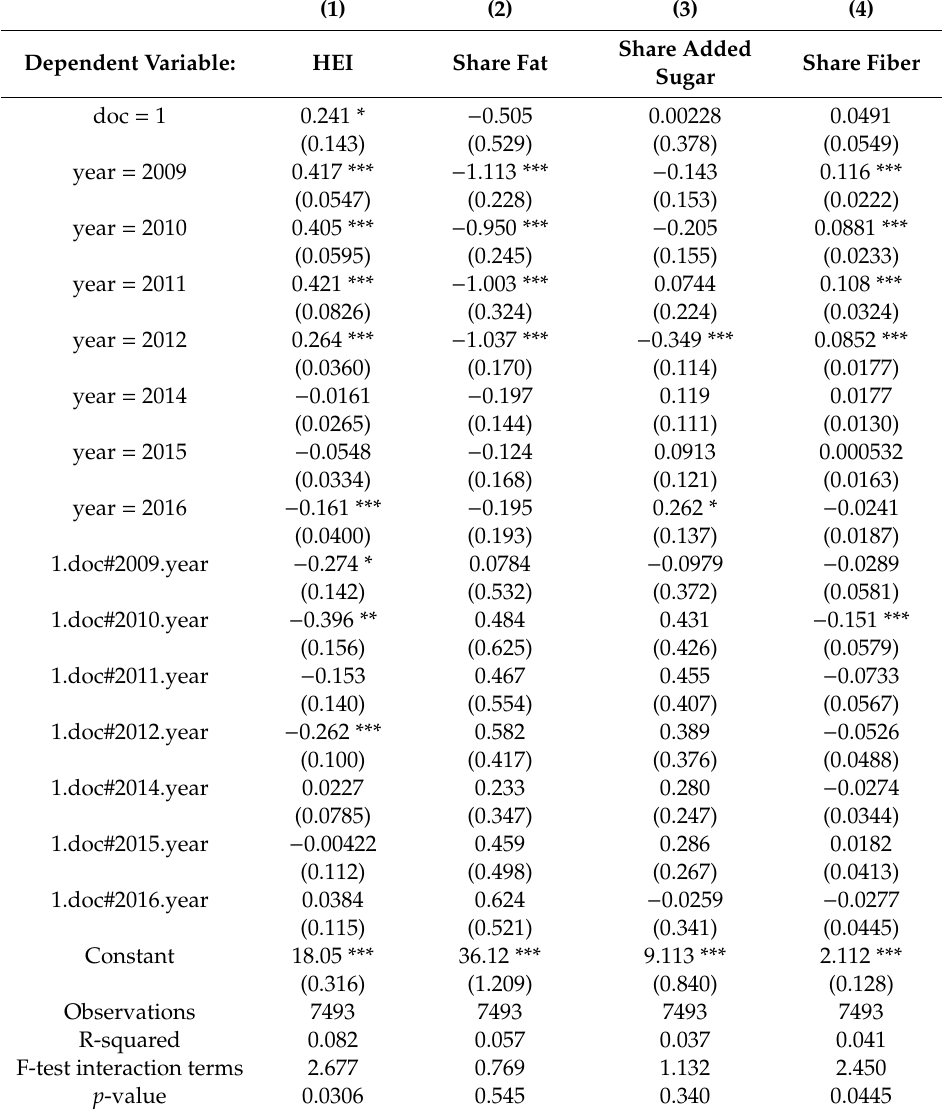
Table A7. Test of common trend of DoC switchers and extended control group.